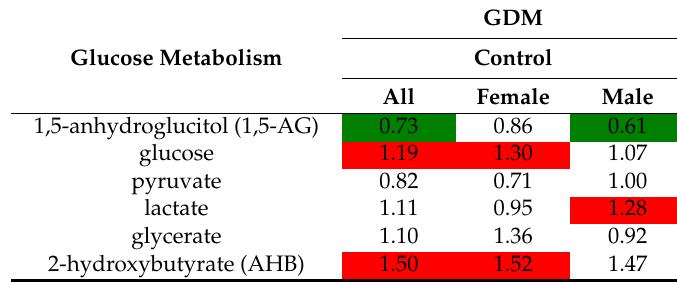
GDM Control All Female Male